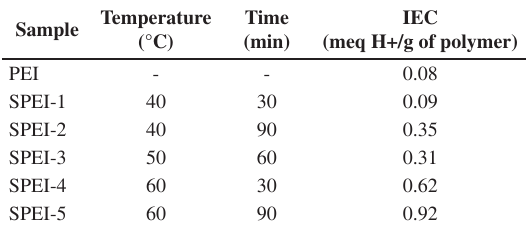
Table 1. IEC of PEI and SPEI’s at different reaction